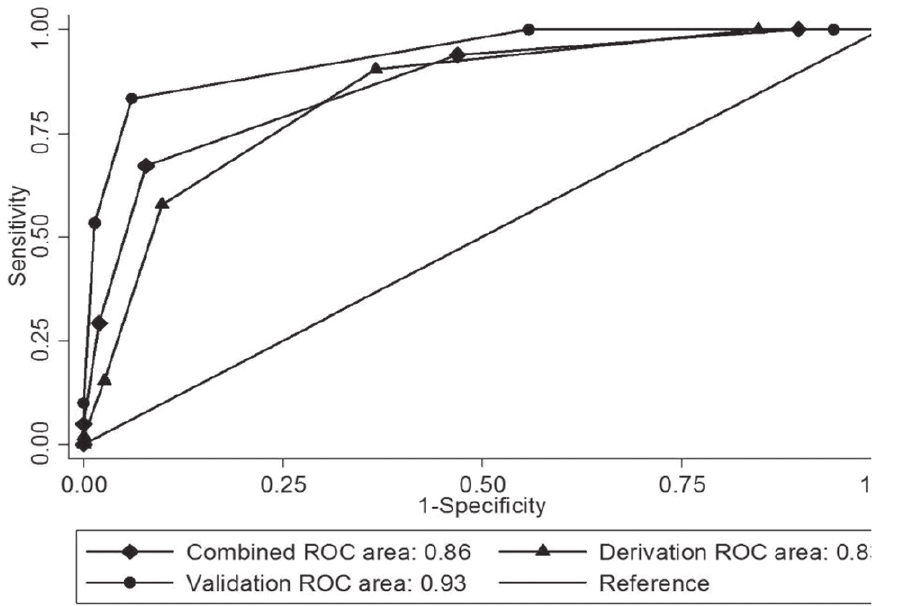
Figure 2. Receiver operator characteristic curves (ROC) for the scoring system in the derivation set, validation set, and combined